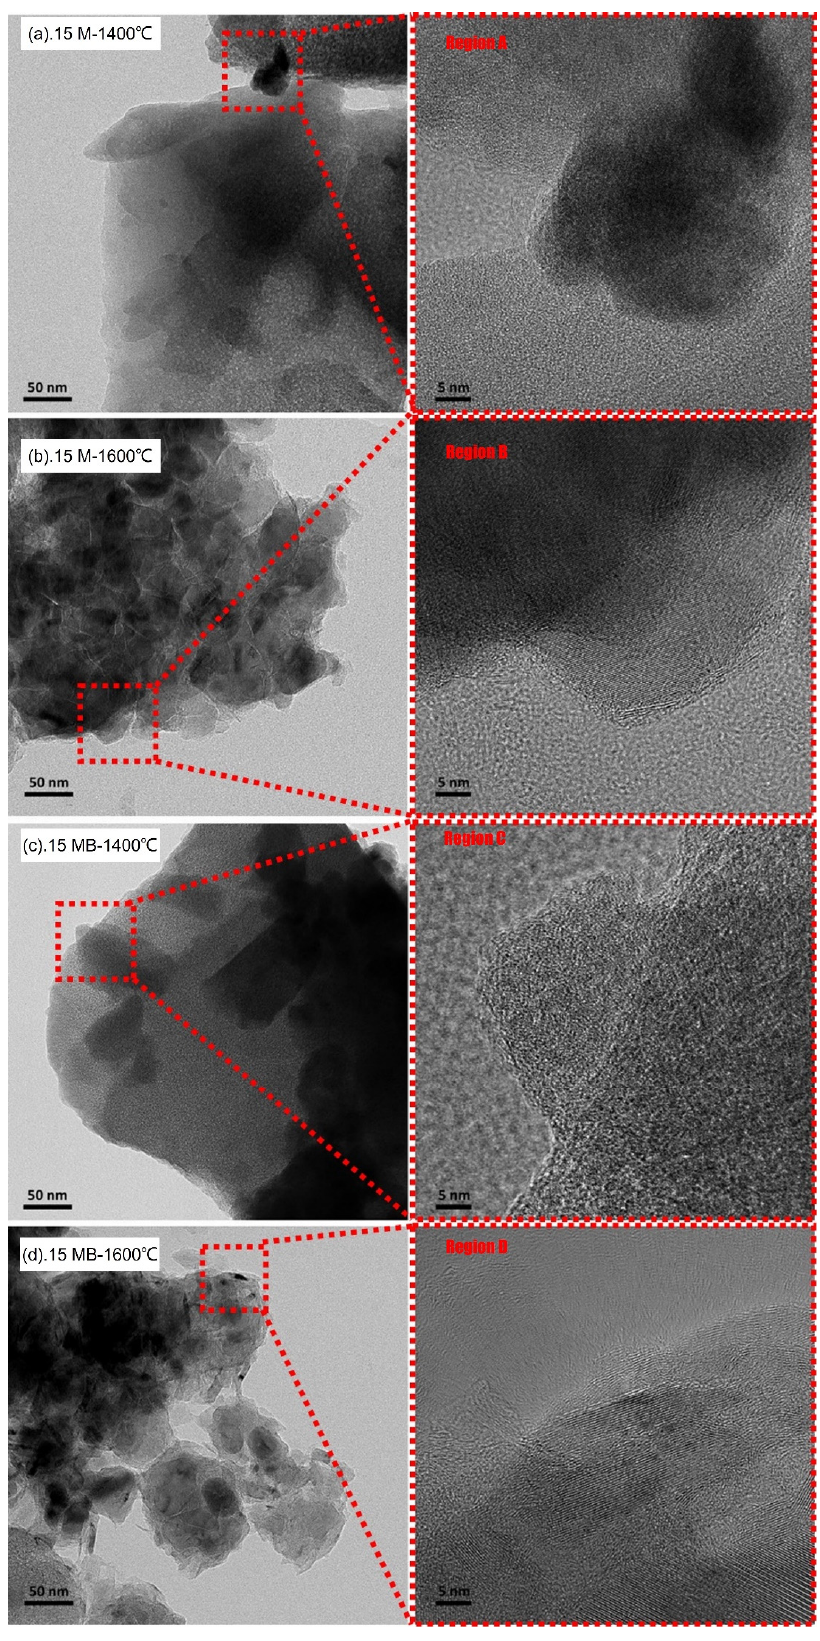
Figure 9. TEM images of the pyrolysis products of ( a ) 15 M, ( b ) 15 M, ( c ) 15 MB and ( d ) 15 MB at different